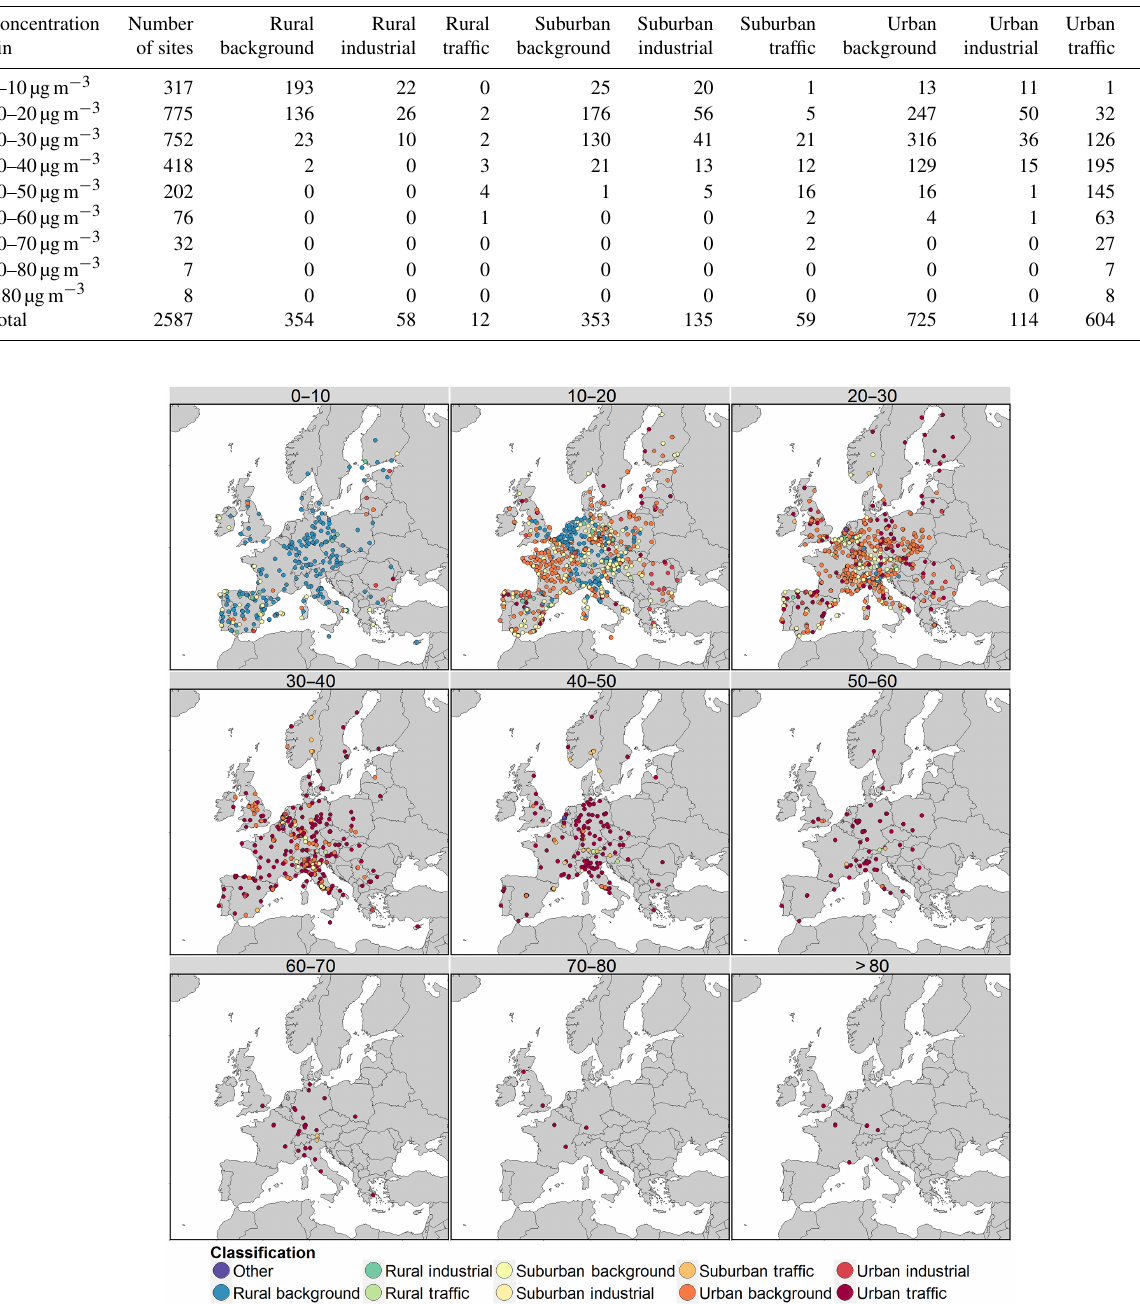
Table 1. The number and classification of sites for which 2010–2014 average annual NO 2 concentrations were calculated, separated into 10µgm − 3 bins.